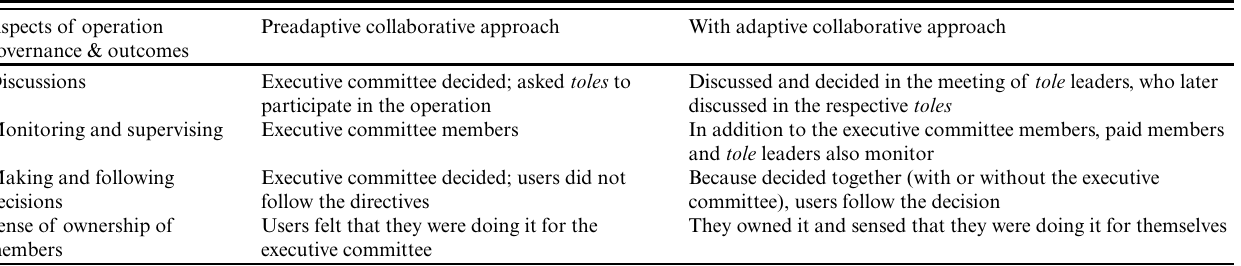
Table 3 . Changes in working approach and ownership: thinning and pruning operation pre- and with-adaptive collaborative approach (2004 and 2007 compared). Source: Notebook record of local